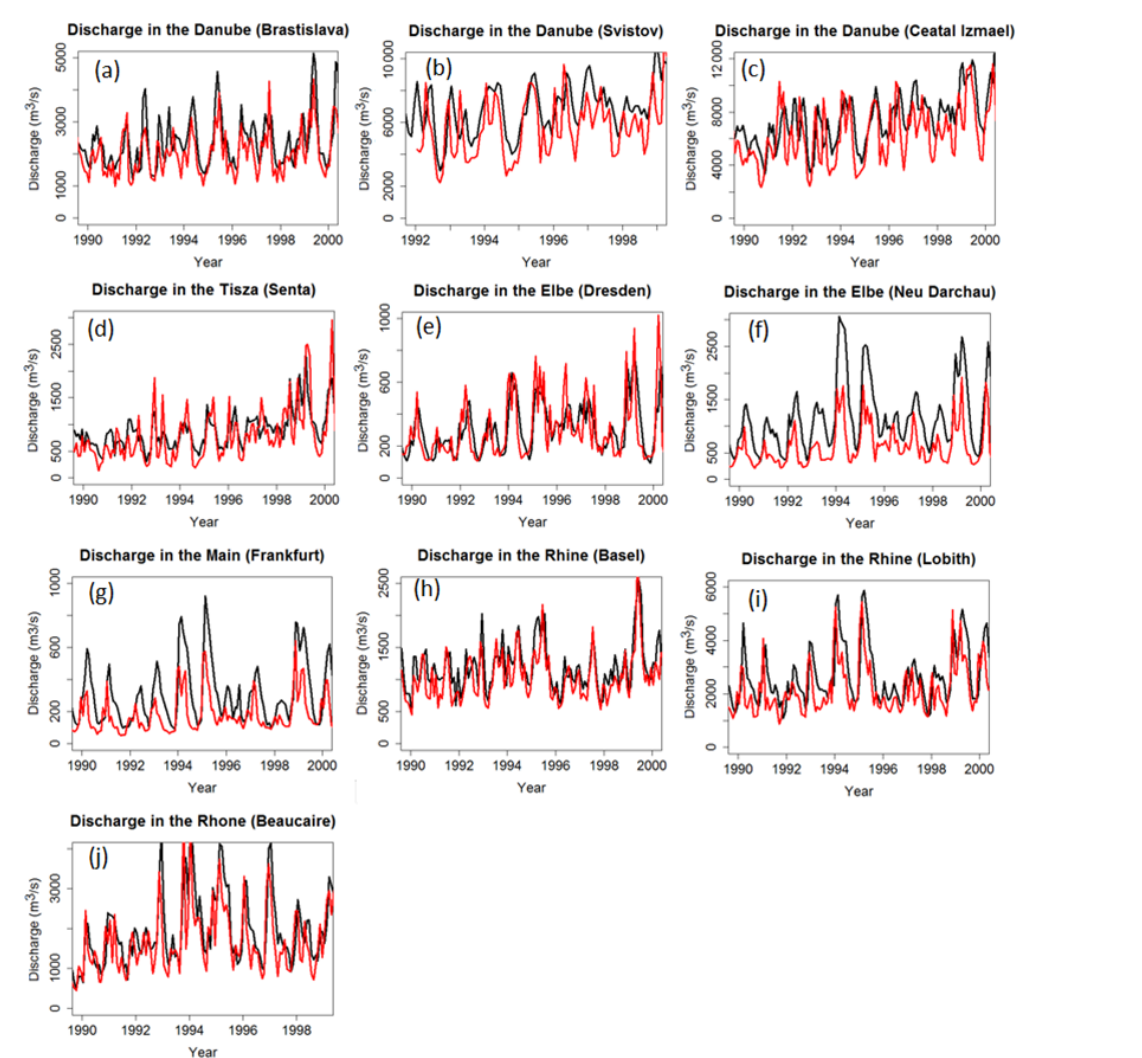
Figure 4. Modeled (black) and observed (red) time series of discharge at the GRDC gauging stations on the Danube (a–c) and its tribu- taries (d) , the Elbe (e, f) , the Rhine (h, i) and its tributaries (g) and the Rhône (j) . Note the different time periods of measurements. See Fig. 3 for exact